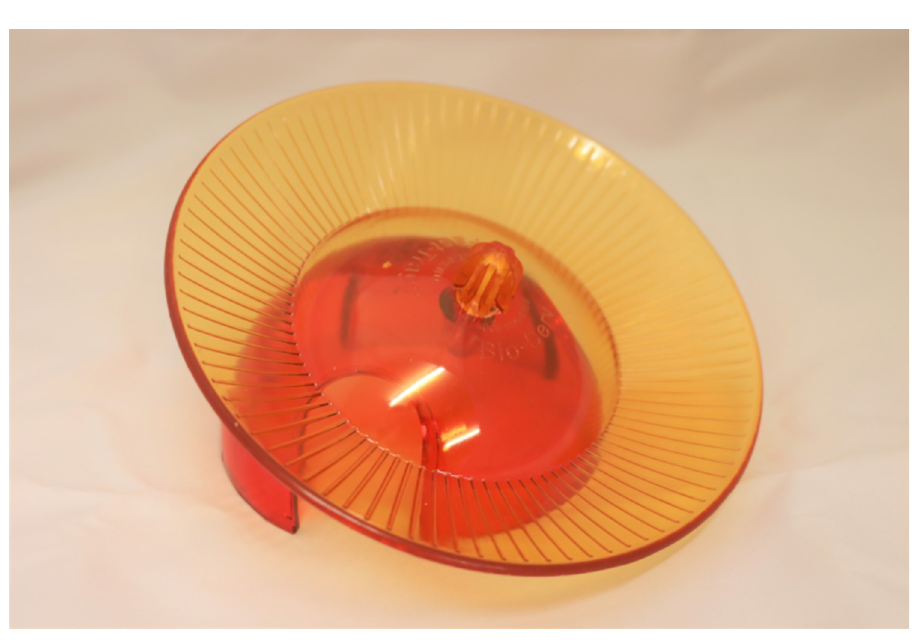
Fig 1. Running disc.